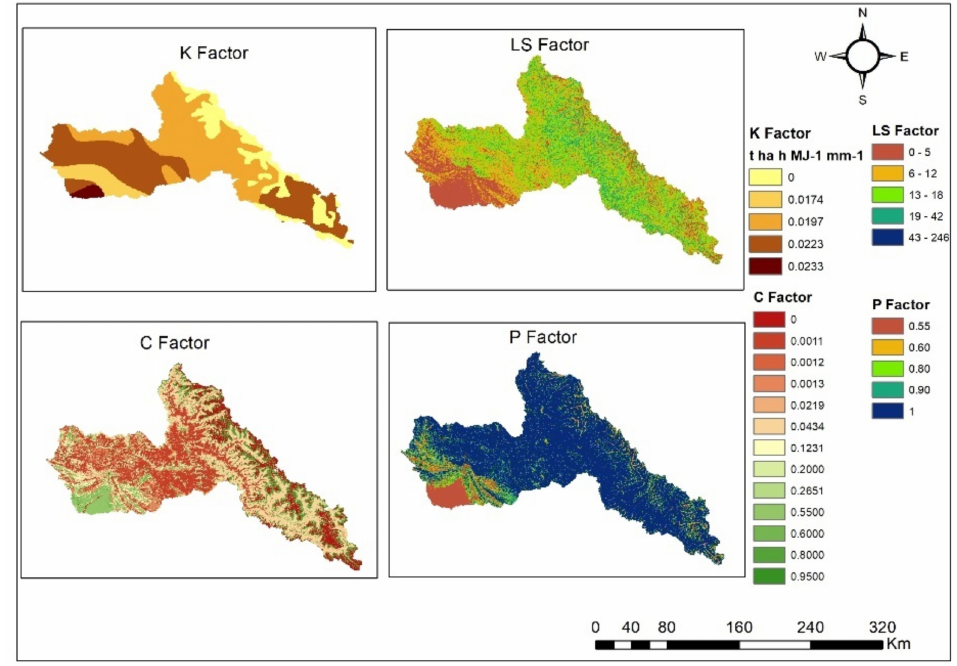
Figure 5. Soil erodibility, slope-length and slope-steepness, cover management, and supporting conservation practice factors in the Chenab river catchment.